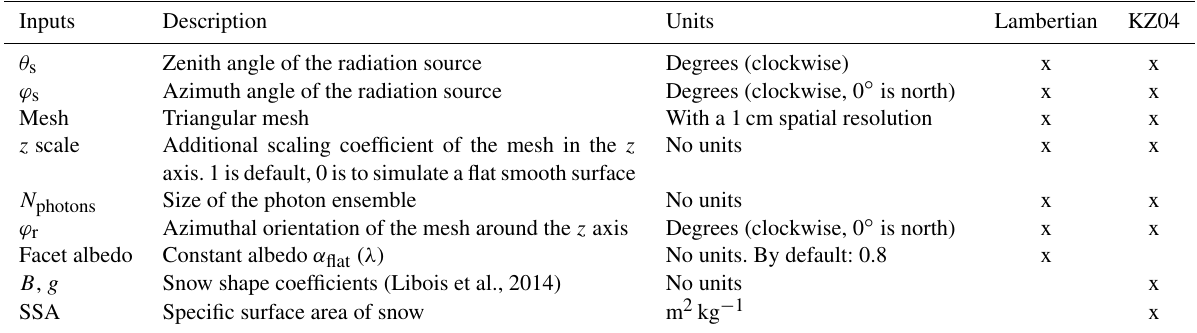
Table 2. RSRT input